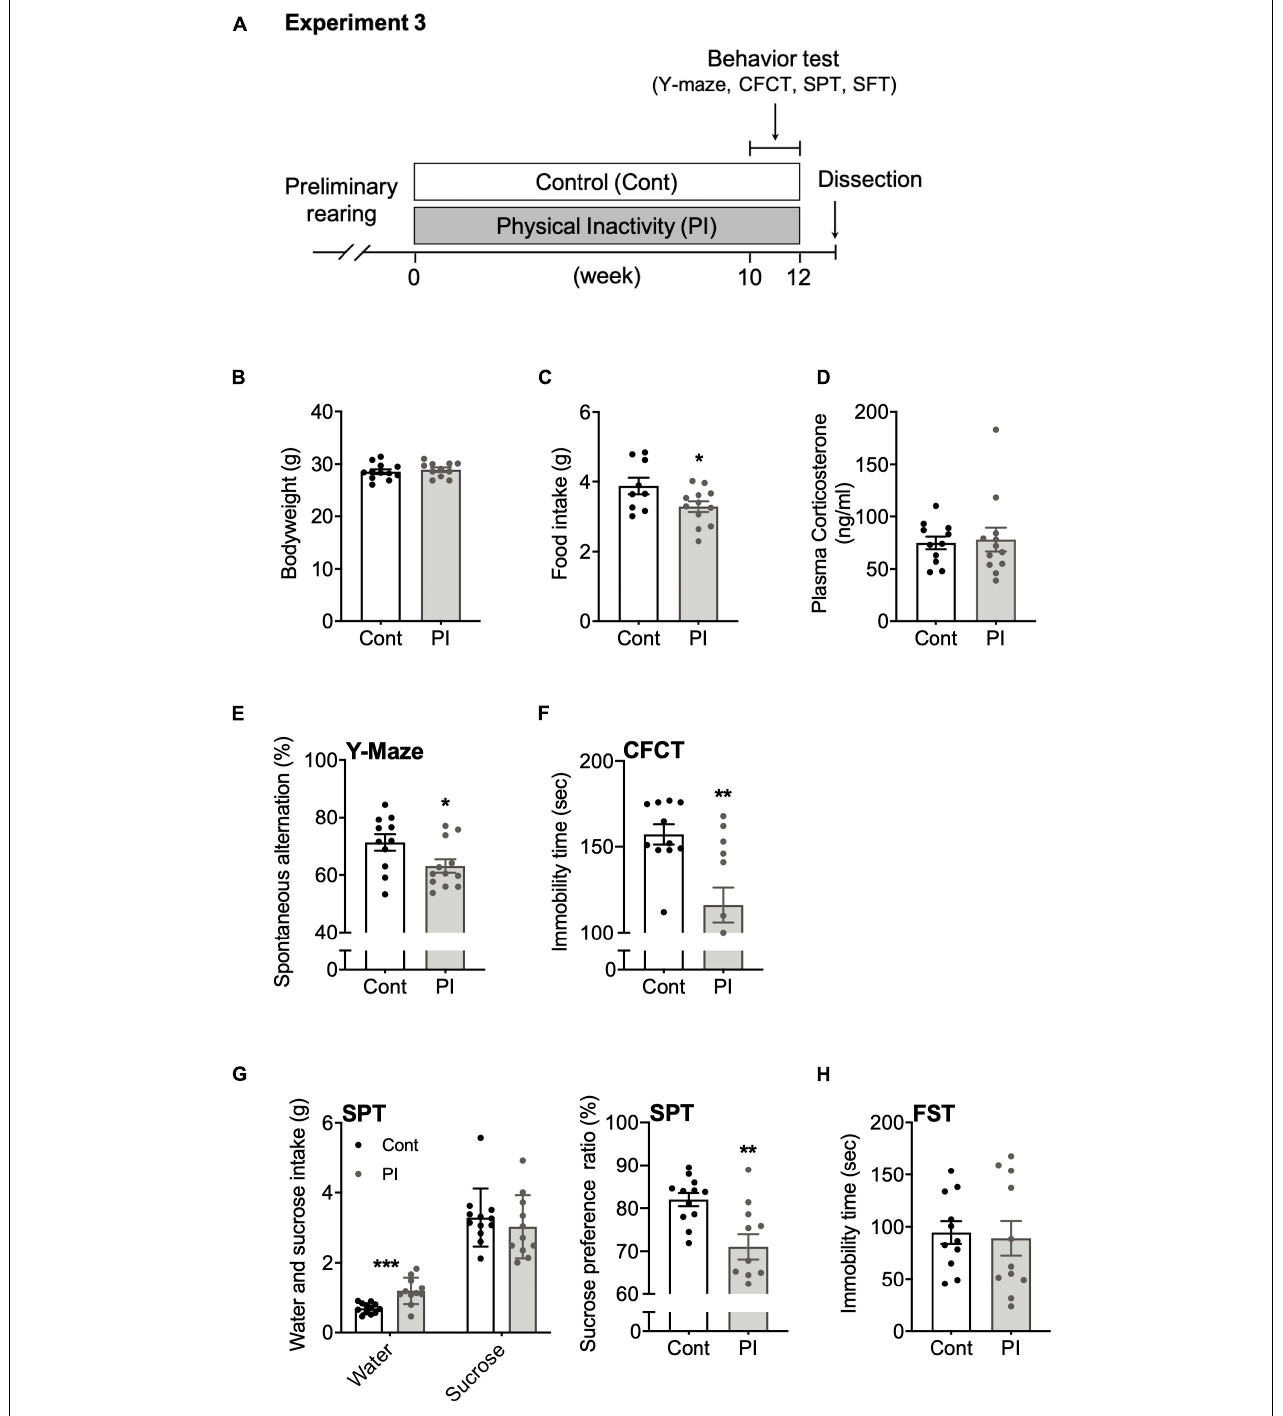
FIGURE 4 | Housing in the PI cage induced cognitive decline and a depression-like state without increasing plasma corticosterone concentration. (A) Experimental protocol for physical inactivity housing for 10 weeks and behavioral tests. (B) Body weight. (C) Food intake on the 10th week. (D) Plasma corticosterone concentration. (E) Accuracy rate in the Y-maze test. (F) Immobility time in the contextual fear conditioning test (CFCT). (G) Sucrose preference ratio in the sucrose preference test (SPT). (H) Immobility time in the forced swim test (FST). All data are presented as the mean ± SEM (Control mice, n = 12; PI mice, n = 11). The Student’s unpaired t -test analyzed data. *p < 0.05, **p < 0.01 in comparison with the Cont mice.